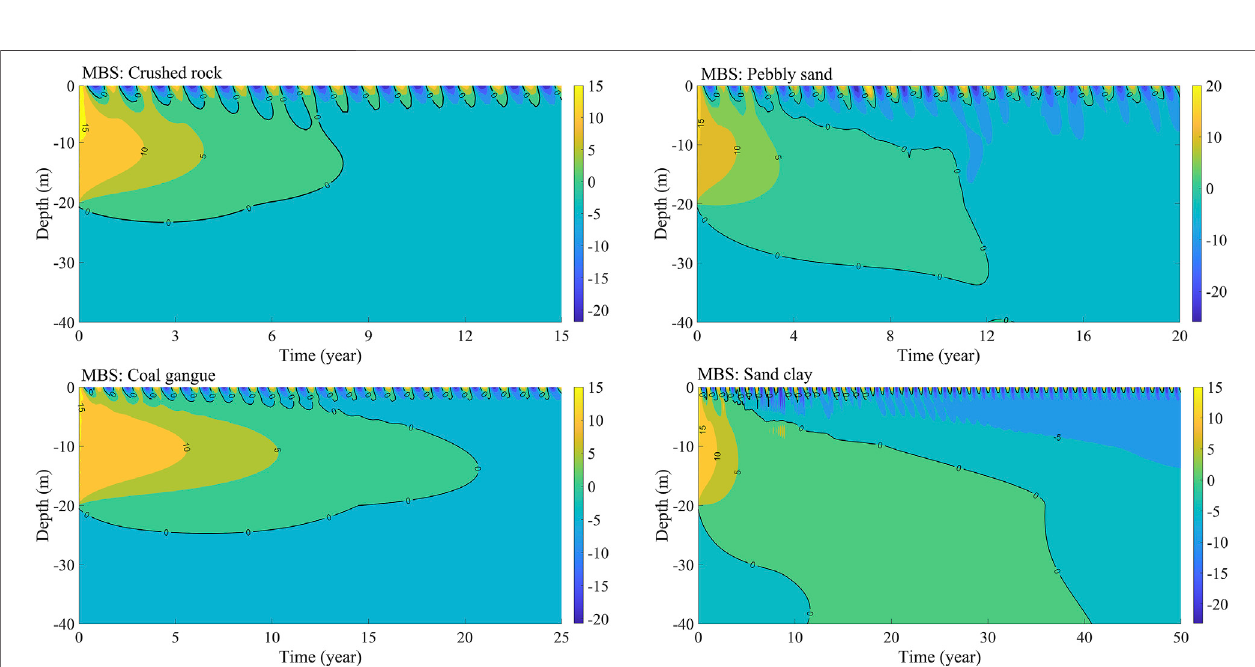
FIGURE 12 | Temporal variations in centerline temperature of different back fi ll soils (crushed rock, pebbly sand, coal gangue, and sand clay).